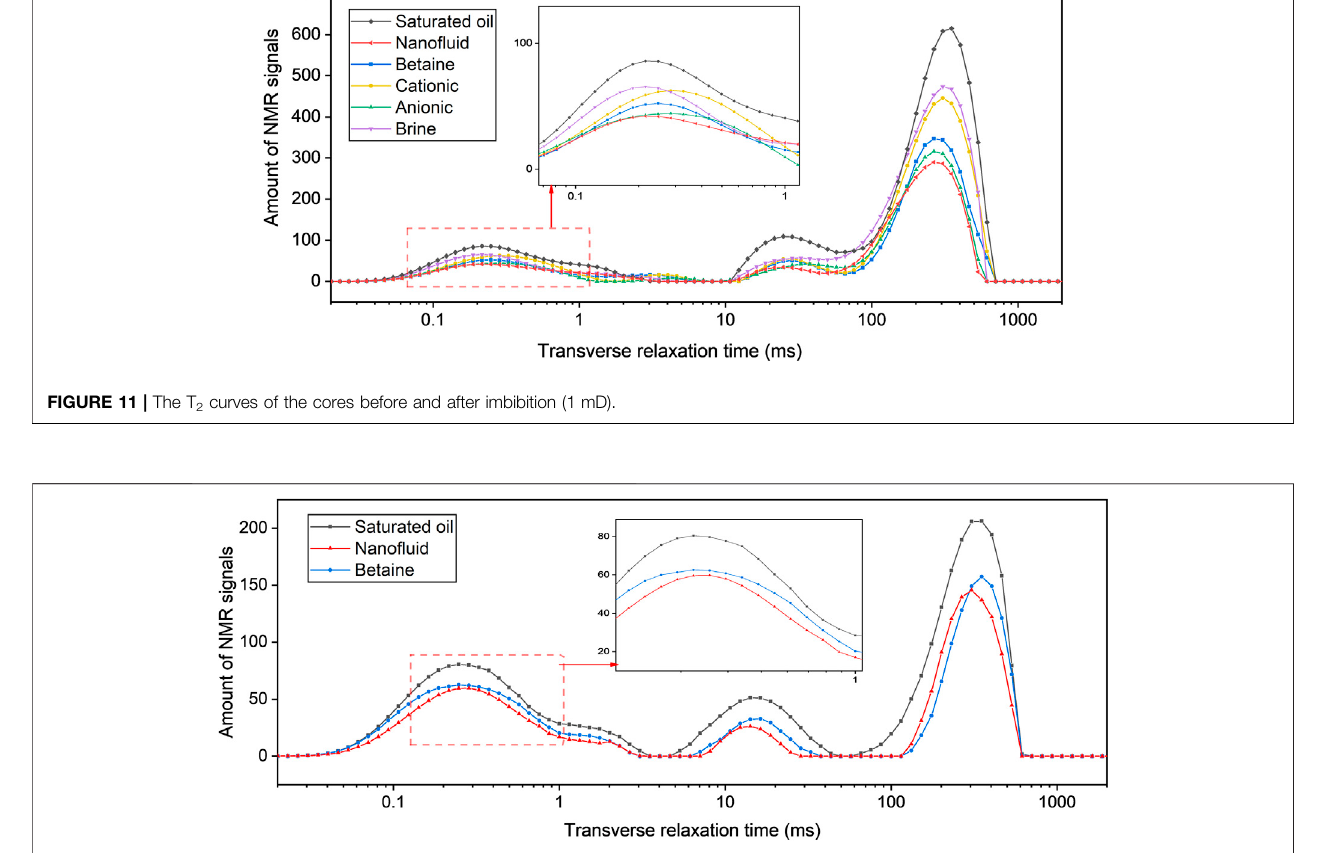
FIGURE 12 | The T 2 curves of the cores before and after imbibition (0.1 mD).